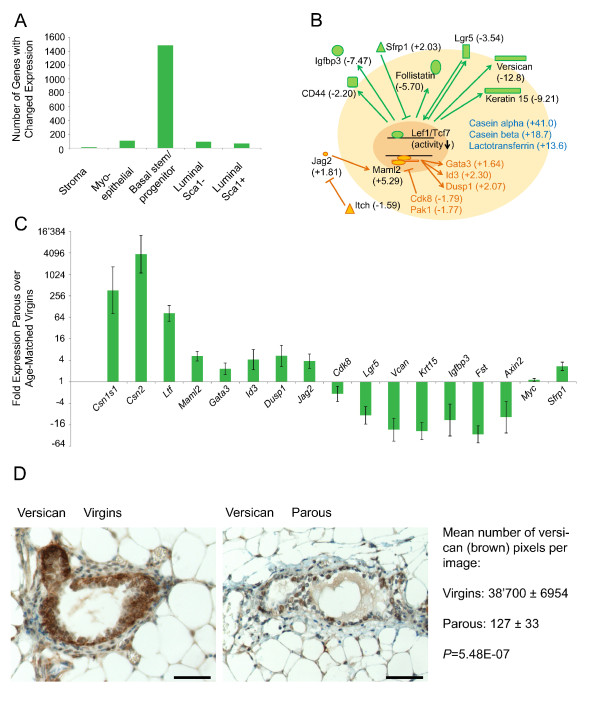
Parity leads to differentiation and decreases the Wnt/Notch signaling ratio in basal stem/progenitor cells. (A) Bar graph depicting the number of gene-expression changes in FACS-sorted mammary stromal and epithelial cell subpopulations from parous mice compared with age-matched virgin control mice by using a cut-off of fold change > 1.5 and an adjusted P value < 0.05. By far the most gene-expression changes were observed in basal stem/progenitor cells. Three independent experiments were performed with 10 mice (five virgins; five parous) per experiment. (B) Schematic illustration of prominent gene-expression changes in FACS-sorted basal stem/progenitor cells from parous as compared with age-matched virgin control mice. Fold changes are shown in parentheses with upregulated genes denoted as positive (+), and downregulated genes, as negative (-). Differentiation genes were upregulated (blue), Wnt target genes were downregulated (green), Wnt inhibitor Sfrp1 was upregulated (green) and overall Notch signaling (orange) was increased in basal stem/progenitor cells from parous mice. (C) qPCR validation of the changes in gene expression in basal stem/progenitor cells of parous mice. All classic Wnt target genes were downregulated, including Lgr5, Axin2, and versican (Vcan), whereas the more ubiquitously regulated target Myc was unchanged. In all cases, fold changes are shown relative to cells from age-matched virgin control mice. Ct values were normalized to the reference genes Hprt and Ubc [63]. Data represent the mean ± SEM of three independent experiments with 10 mice (five virgins; five parous) per experiment. (D) Representative images and quantification of immunostaining for the Wnt target gene versican in mammary gland sections from age-matched virgin and parous mice in estrus. Scale bar, 50 μm. Quantitative data represent the mean ± SEM from 60 randomly selected images from three virgin and three parous mice.